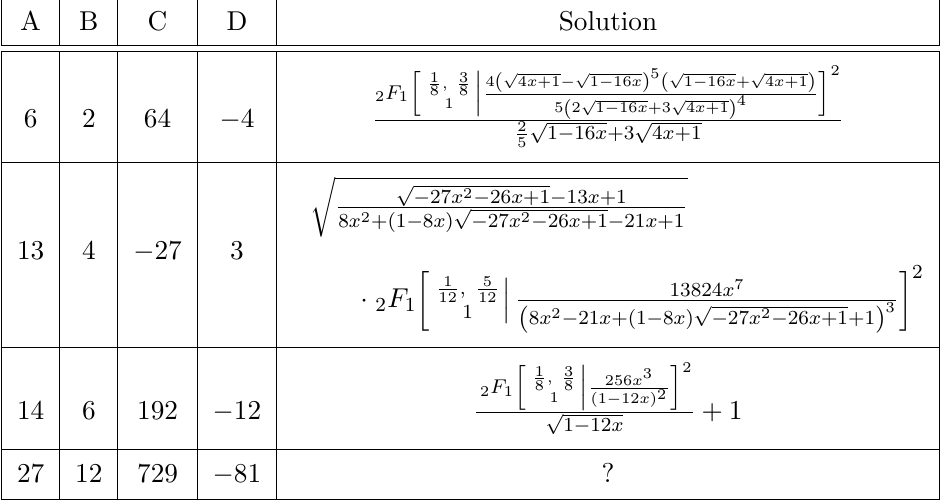
( a, 1 − a ; 1; x ) type. The last row follows from the 2 F 1